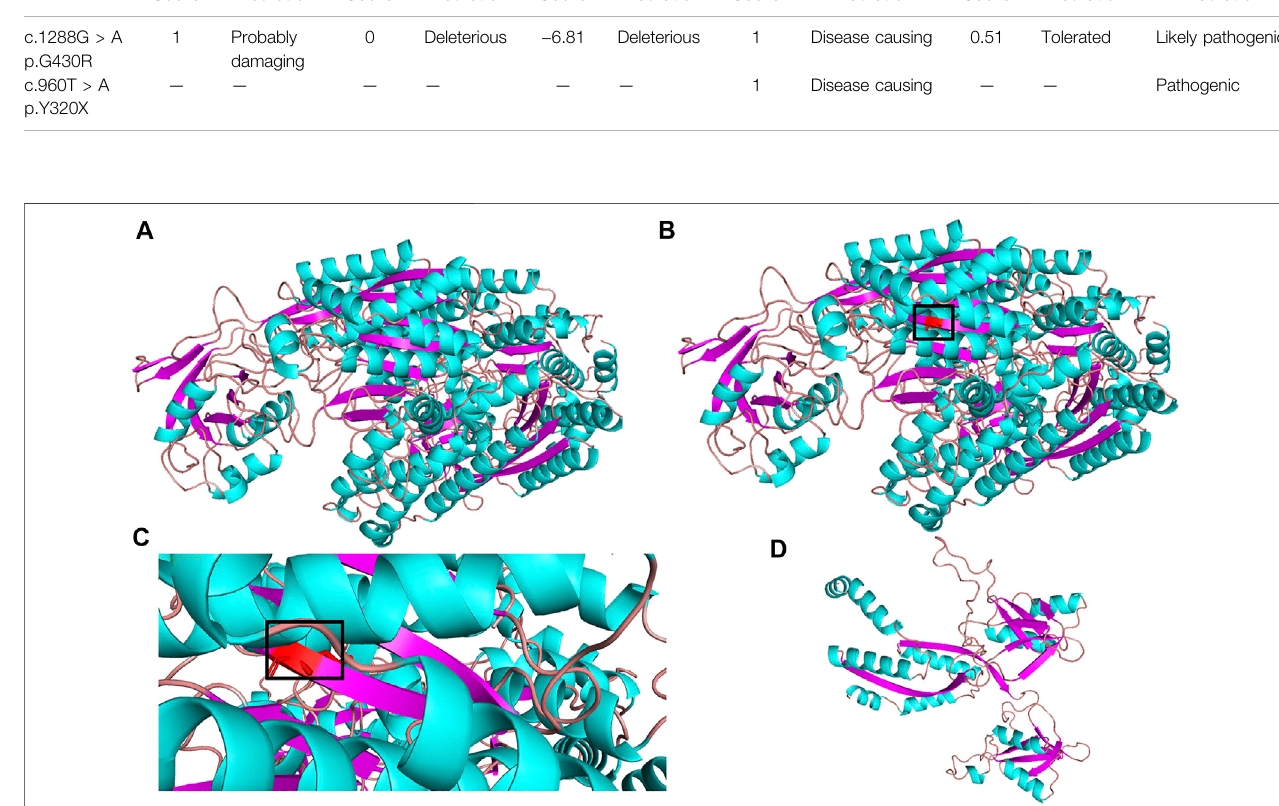
FIGURE 3 | 3D structure of TFR2 protein. (A) wild-type; (B) mutant type c.G1288A (p.G430R); (C) partial mutation graph c.G1288A (p.G430R); (D) mutant type c.T960A